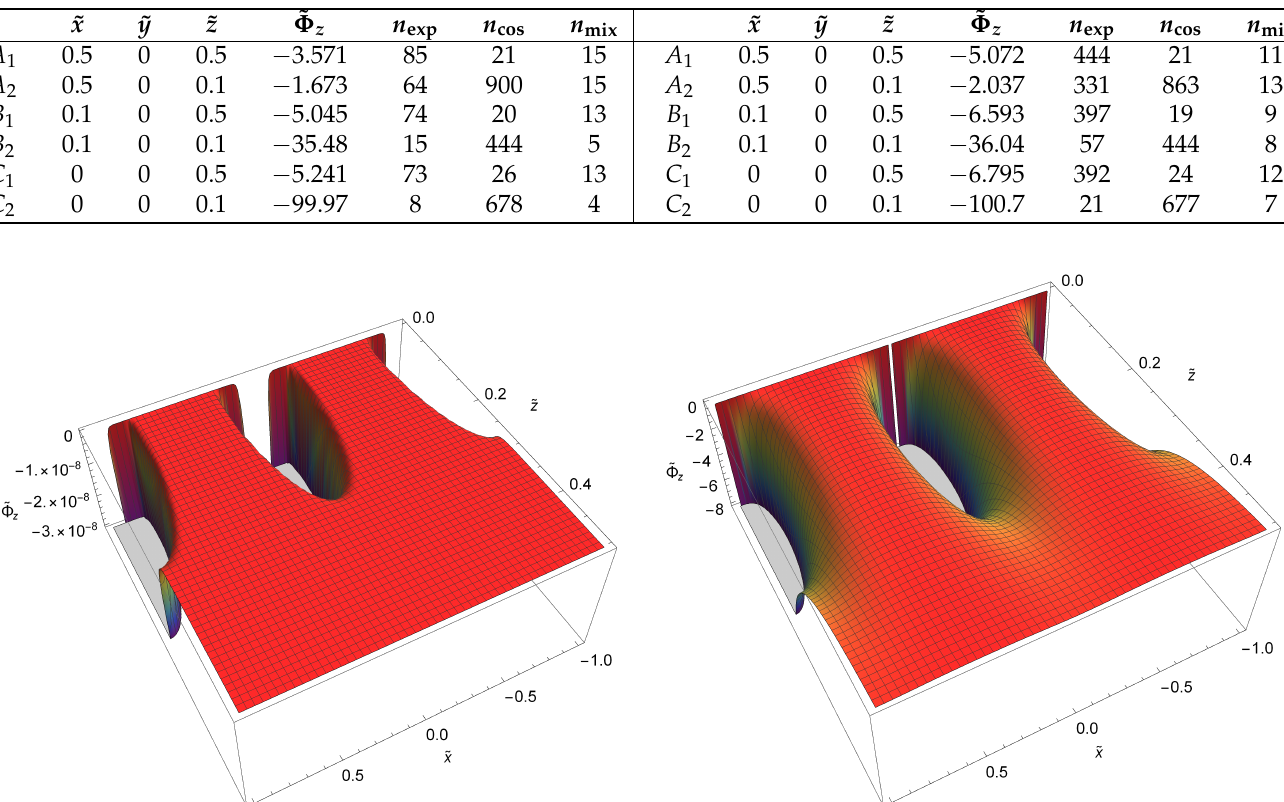
Table 6. Numerical values of the z -component of the rescaled force ˜ Φ z ≡ ∂ ˜ Φ / ∂ ˜ z as well as the numbers n exp , n cos and n mix for points A 1 , A 2 , B 1 , B 2 , C 1 and C 2 for ˜ λ eff = 1 and ˜ λ eff = 3 in the left and right tables, respectively.